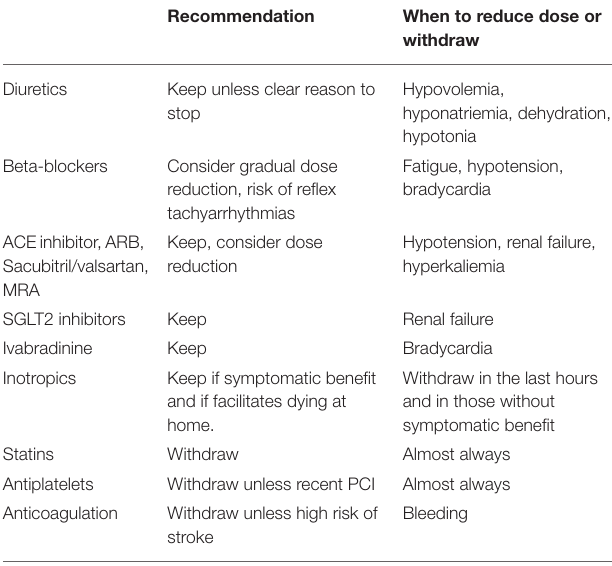
TABLE 1 | A six-step protocol for delivering bad news. Setting